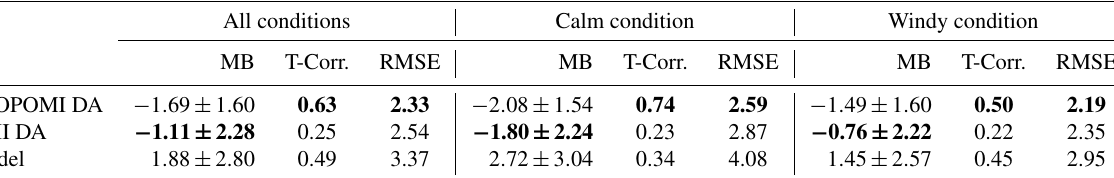
Table 6. Mean bias (MB), temporal correlation coefficient (T-Corr.), and root-mean-square error (RMSE) for surface NO 2 at 14:00LT (local time) against in situ observations from the Air Quality System (AQS) over Los Angeles from 15 April–31 May 2018 under all, calm (wind speed ≤ 2 . 5ms − 1 ), and windy conditions. Both MB and RMSE are expressed in parts per billion by volume (ppbv). Boldface denotes the best agreement with in situ observations. The range of the MB is the standard deviation of the time series. “Model” indicates the control model simulation.